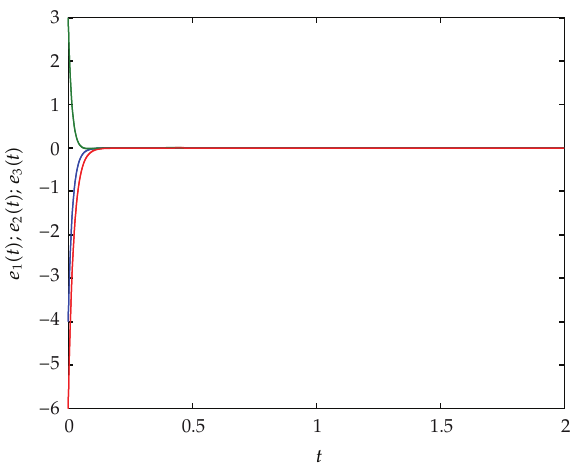
Figure 2: Synchronization errors of systems (cid:3) 2.1a (cid:4) – (cid:3) 2.1d (cid:4) and (cid:3) 2.2a (cid:4) – (cid:3) 2.2d (cid:4) with a (cid:8) 0 . 4 and α (cid:8)